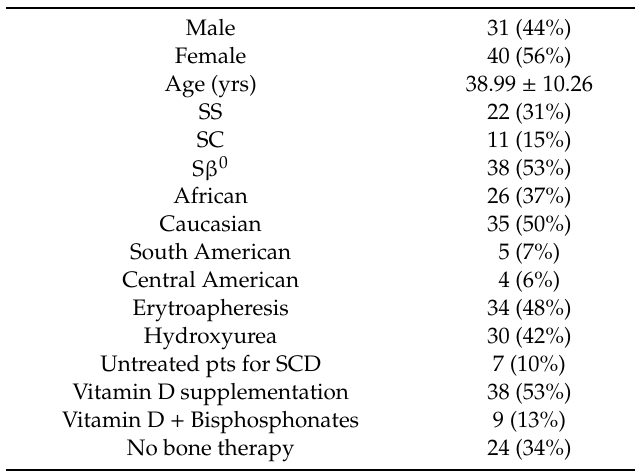
Table 1. Demographic data of SCD